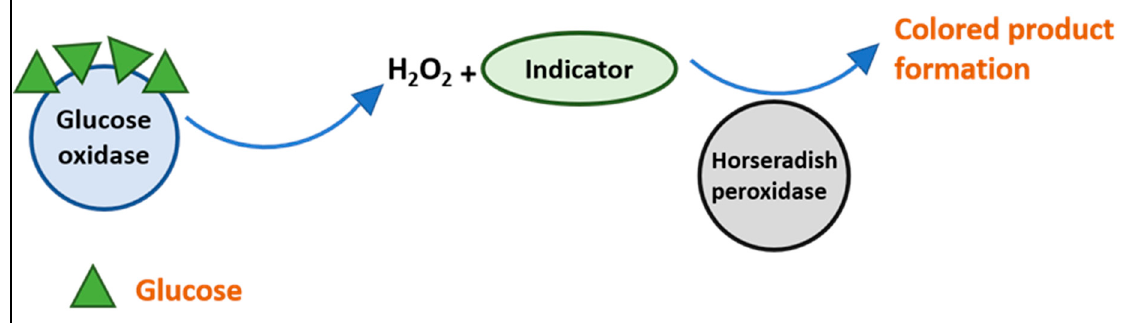
7 of 16 Figure 4. Schematic representation of the dimensions and design of the paper pad. 2.5. Reagent Preparation For the glucose assay, two different concentration ranges were chosen; the first was 0.1–0.5 M with a difference of 0.1 M for the color development, and the other was 0.5–20 mM. The reason for selecting these values was that normal blood glucose levels lie in this range. To obtain both concentration ranges, glucose was dissolved in PBS (0.1 M, pH 6.0). KI, glucose oxidase, and HRP were dissolved in PBS (0.1 M, pH 6.0) to obtain 0.6 M, 120 U/mL, and 100 U/mL of stock solution. The prepared stock solution was kept in a refrigerator at 4 °C, ceasing from the light, while the KI was stored at room temperature, wrapped with aluminum foil to protect from light for further use.